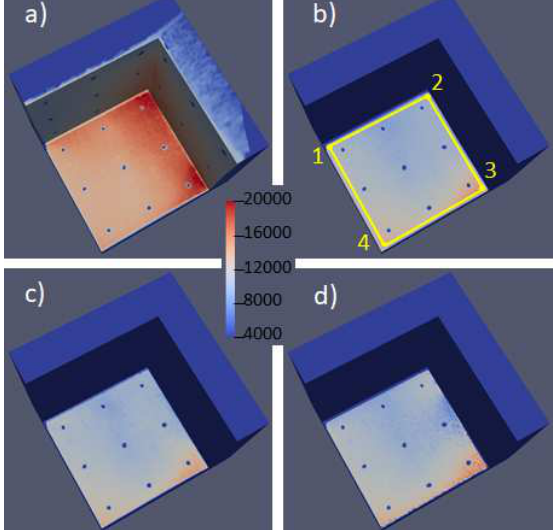
Fig. 4. Brightness maps on a 3D-model. a) 3-surface configuration, not corrected, b) single-surface configuration, c) 3-surface configuration, corrected with average R , d) 3-surface configuration, corrected with distributed Ri .